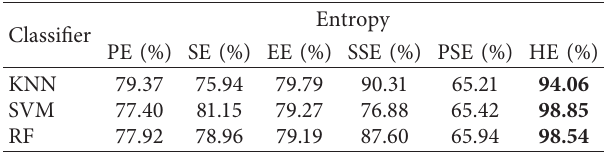
Table 3: Diagnosis results of different classifiers with different entropy